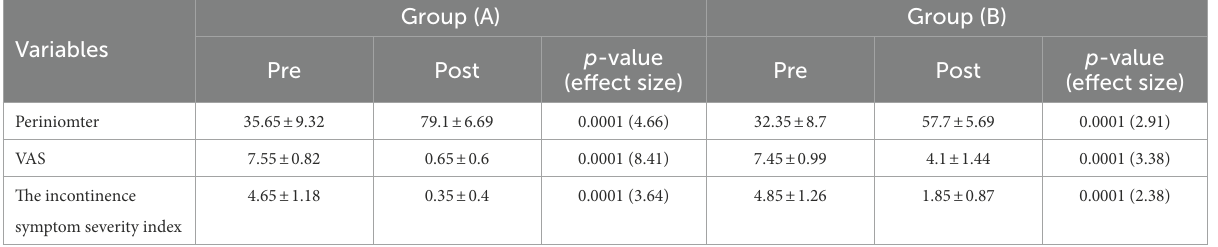
TABLE 3 Descriptive statistics for all VAS, the incontinence symptom severity index and Periniomter for both groups at different training periods.